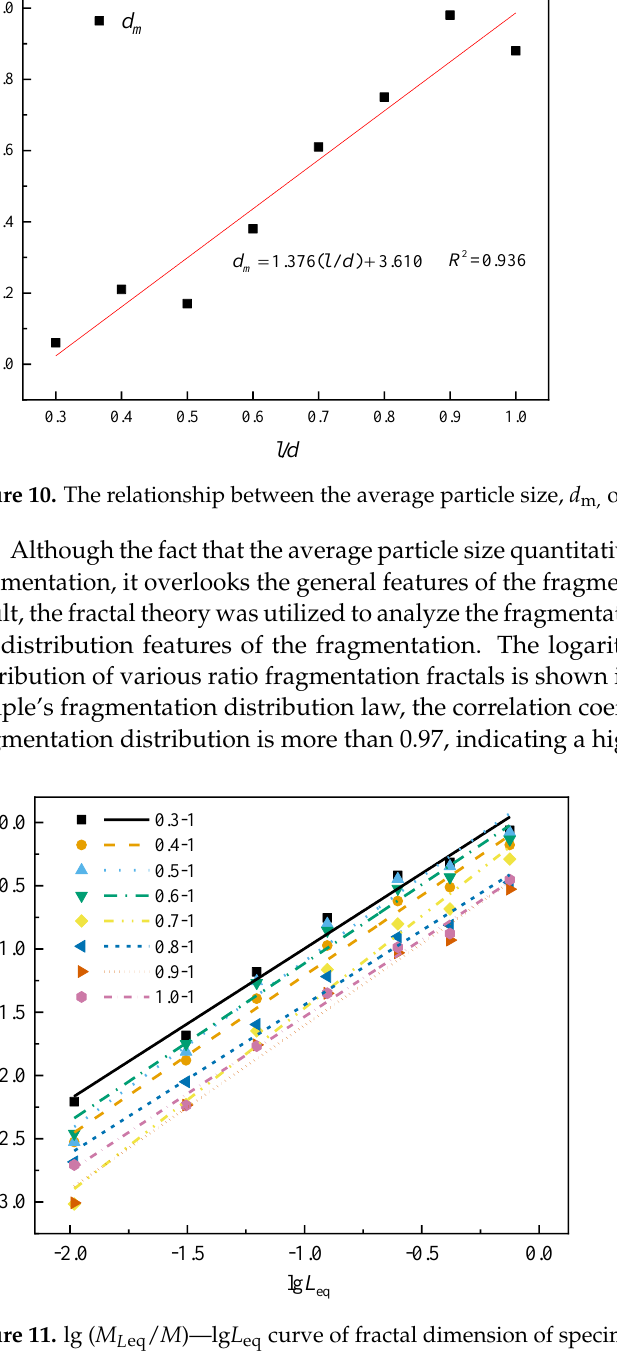
Figure 12. The relationship between average fractal dimension and l / d . 4.3. Crushing Density Energy Efficiency Coal fragmentation is the result of the continuous initiation, development, expan- sion, and propagation of cracks, which is a process of energy dissipation. Therefore, the distribution characteristics of specimen fragments and their energy dissipation are asso- ciated inherently and inevitably. According to Hong ’ s study [23], the crushing energy consumption of rock fragmentation is mostly dependent on incident energy and increases linearly. The amount of energy used is proportional to the material characteristics and microstructures. It has nothing to do with the loading rate or sample size when the ratio is the same. In terms of fractal dimension features, the crushing energy consumption per unit volume of the specimen is more directly linked to its crushing degree. Figure 13 shows the fractal dimension – energy consumption density variation curve for specimens of various ratios.